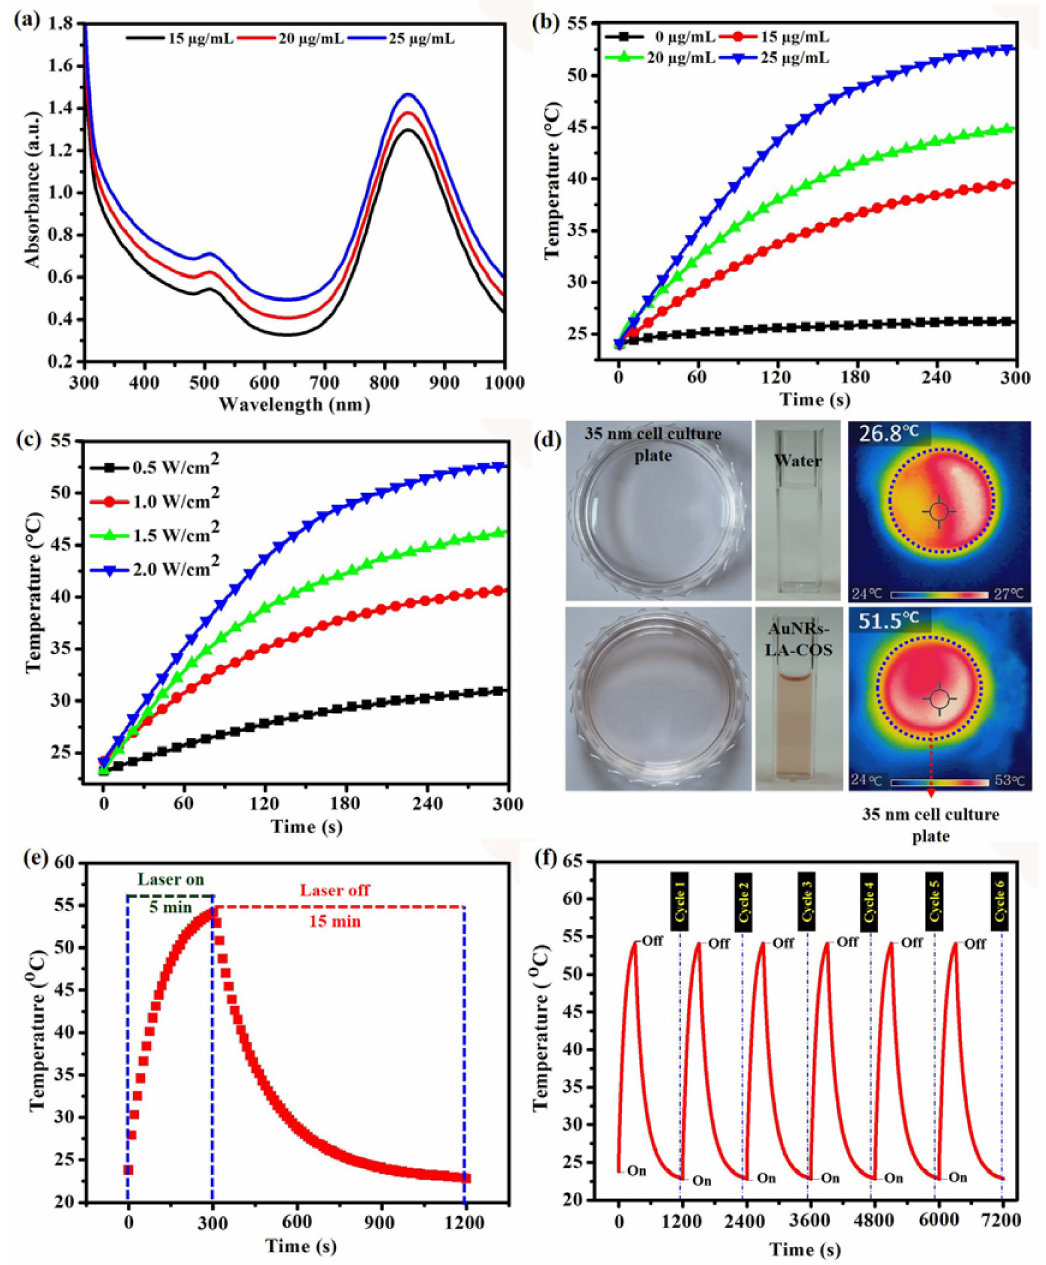
Figure 3. ( a ) UV-Vis-NIR absorbance spectra of different concentrations of AuNRs-LA-COS. ( b ) Temperature changes of different concentrations of AuNRs-LA-COS aqueous solutions under 808 nm NIR laser irradiation at 2.0 W/cm 2 for 5 min. ( c ) Temperature changes of aqueous solution at a concentration of 25 µ g/mL under 808 nm NIR laser irradiation at different power densities (0.5, 1.0, 1.5, and 2.0 W/cm 2 ) for 5 min. ( d ) IR thermographs of water and AuNRs-LA-COS (25 µ g/mL) solution in 35 mm cell culture plate under exposure to an 808 nm NIR laser irradiation at 2.0 W/cm 2 for 5 min. ( e ) Heating and cooling curves of AuNRs-LA-COS (25 µ g/mL). The laser lasted for 5 min, and then the laser was turned off for 15 min. ( f ) The change of temperature increase of AuNRs-LA-COS (25 µ g/mL) for six laser on/off cycles NIR laser irradiation at 2.0 W/cm 2